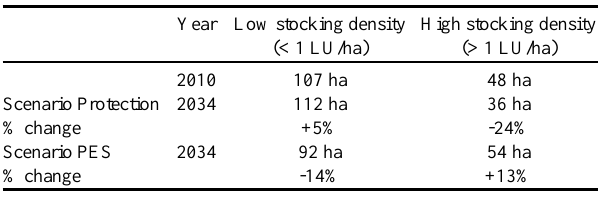
Table 2 . Change in simulated agricultural land-use intensities between 2010 and 2034. PES = Payment for environmental